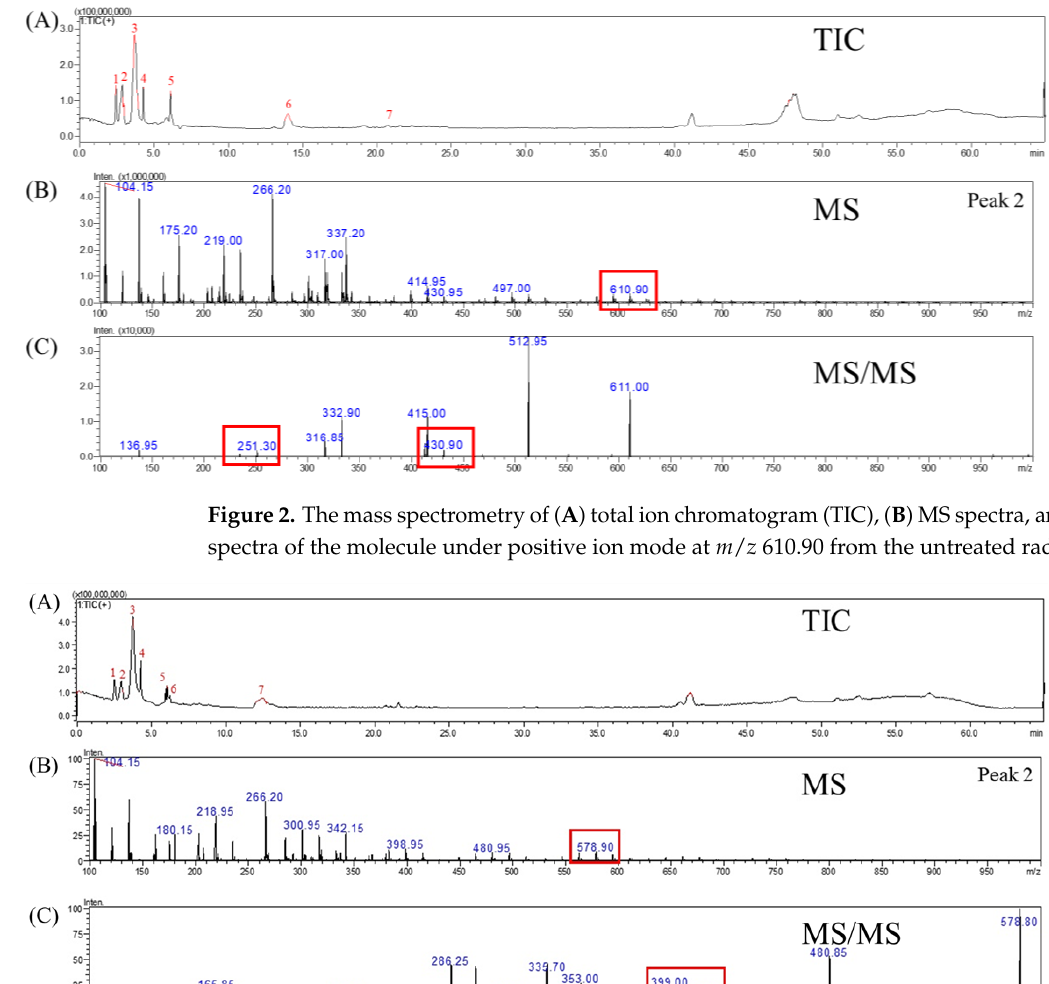
Figure 4. The mass spectrometry of ( A ) total ion chromatogram (TIC), ( B ) MS spectra, and ( C ) MS/MS spectra of the molecule under positive ion mode at m / z 578.95 from the thermally treated radish at 70 °C for 30 days.